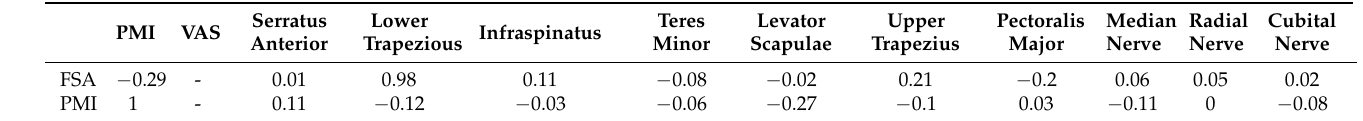
Table 4. Spearman’s Rho correlations in Control